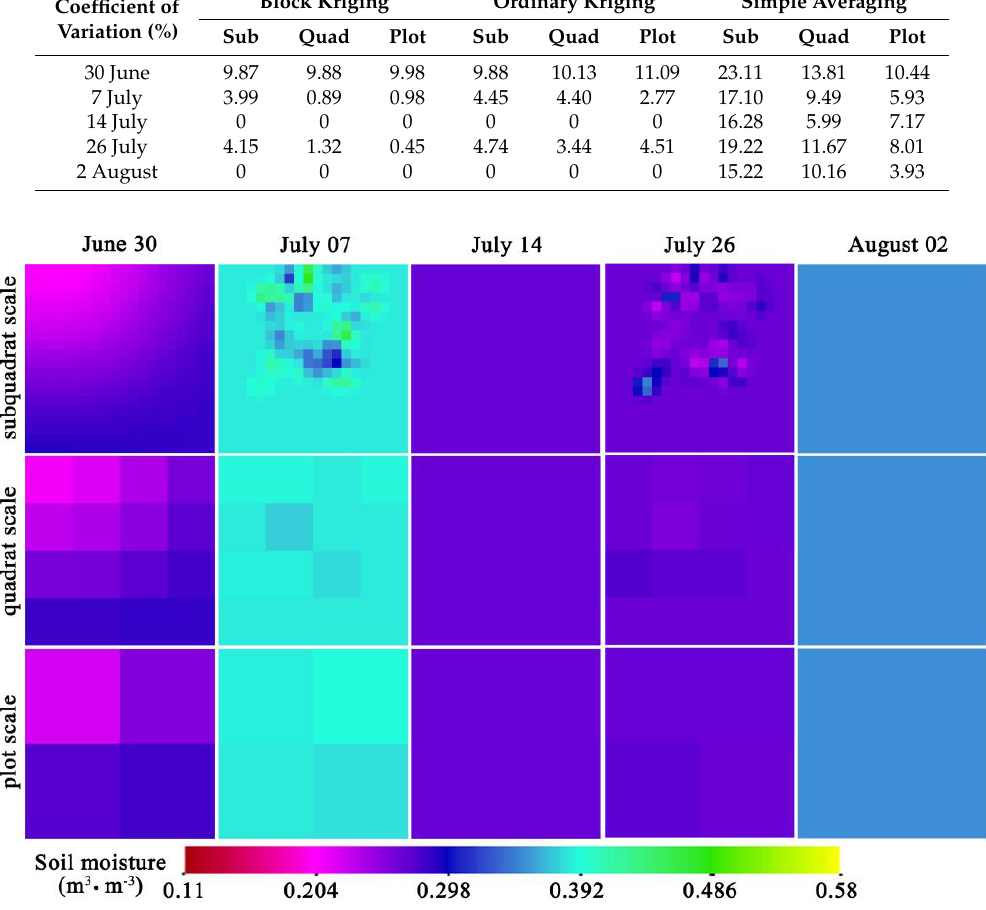
Table 3. Coefficients of variation of upscaled soil moisture estimations at the scale series on five acquisition dates. Sub: subquadrat scale. Quad: quadrat scale. Plot: plot scale. Coefficient of Variation (%)